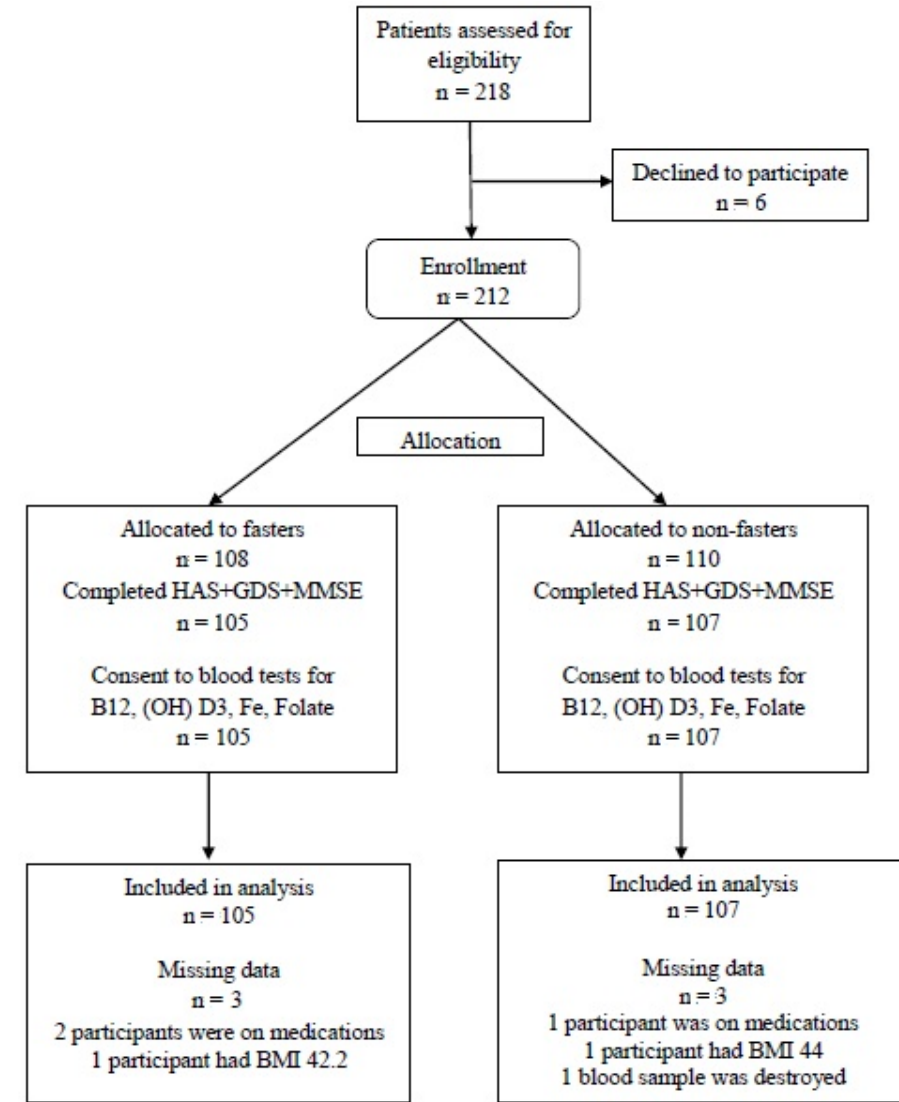
Figure 1. Participants Flow Chart.